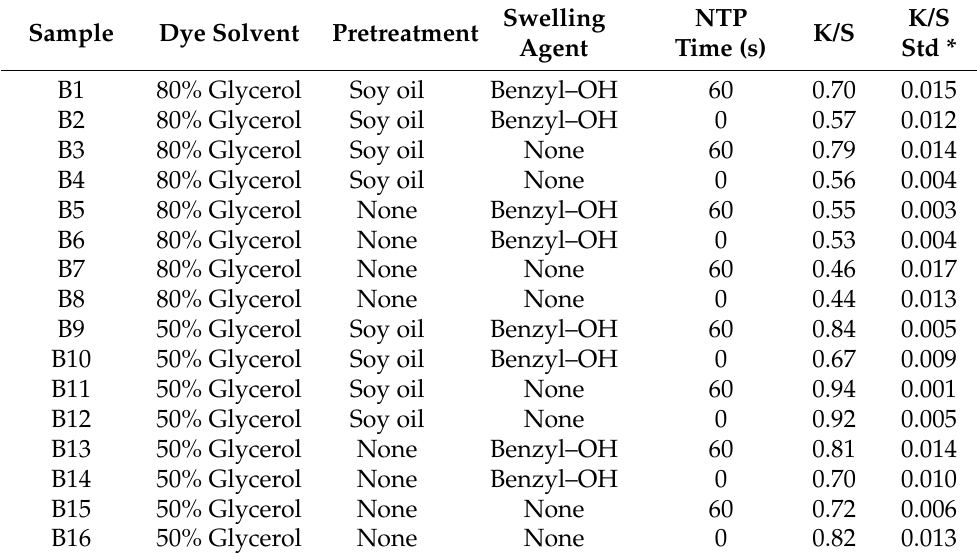
Table 2. Experiment B: experimental design and results @